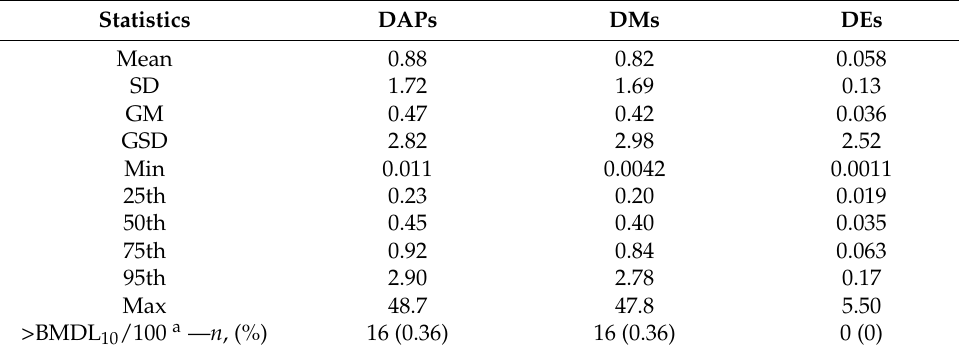
Table 2. Estimated cumulative OPP dose equivalents ( µ g/kg/day, n =